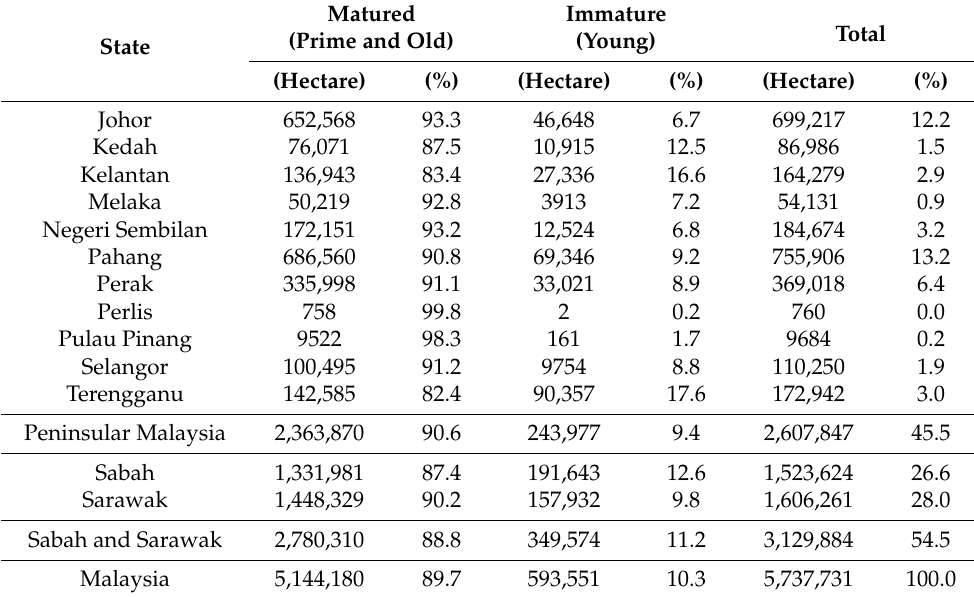
Table 3. Oil palm planted area (hectare) in Malaysia as of December 2021 [52].